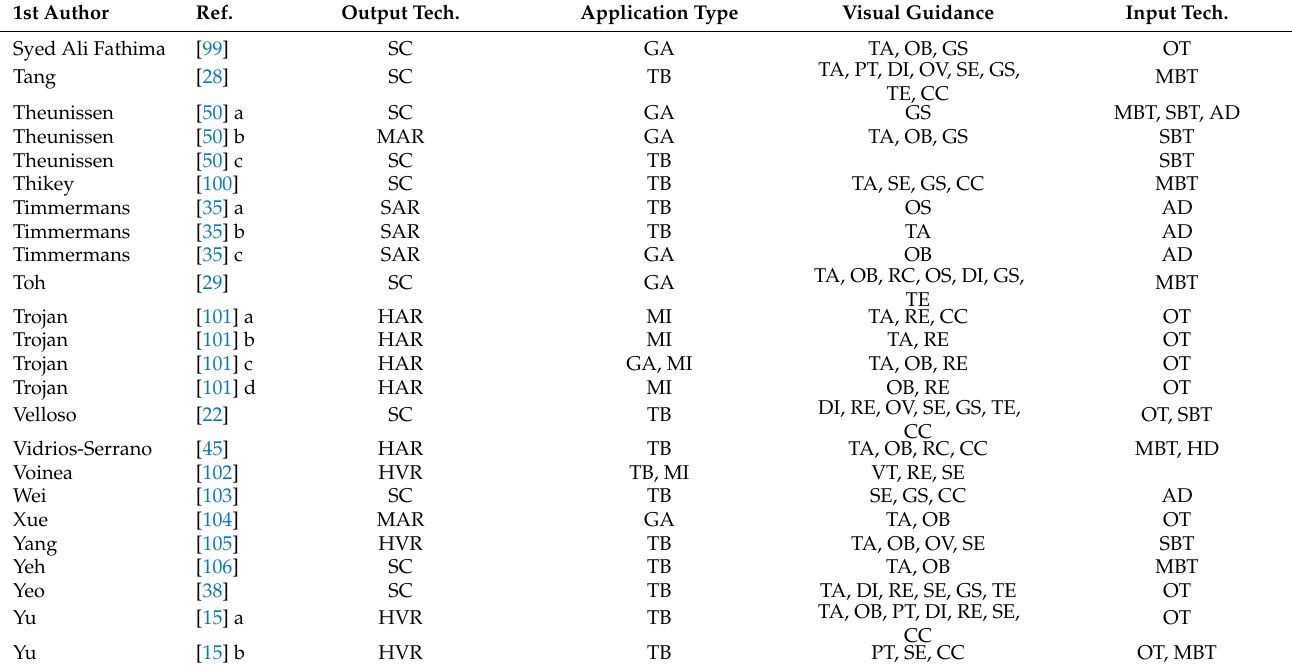
Table A6. Overview of the selected references—author names Sy–Z, part 2/2, Abbr. in Table A7. Distinct applications within a reference are marked with lowercase